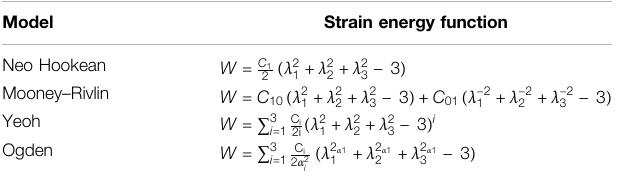
TABLE1| StrainEnergyfunctionsforincompressiblehyperelasticmaterials(Mihai and Goriely,